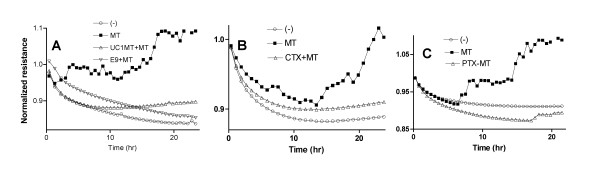
Inhibitors of MT chemotaxis. A: Monoclonal anti-metallothionein antibody blocks the chemotactic response of Jurkat T cells to 20 μM metallothionein gradient. Affinity-purified metallothionein (20 μM) was incubated with antibody (clone UC1MT or E9) and then added to the chemoattractant well. Controls were performed with metallothionein alone (MT), medium alone (-), or metallothionein preincubated with isotype-matched control antibody (not shown). B: Cholera toxin (CTX) inhibits chemotactic response to metallothionein. Jurkat T cells were preincubated with or without 0.133 μg/106 cells/ml CTX at 37°C for 1 h and then added to the cell well. Chemotactic responses of toxin-treated cells to MT (CTX-MT) were compared to untreated cells (MT) and untreated cells without an MT gradient (-). C: Pertussis toxin (PTX) blocks the chemotactic response to metallothionein. Jurkat T cells were preincubated with or without 200 ng/106 cells/ml PTX at 37°C for 16 h. Chemotactic responses of toxin-treated cells to MT (PTX-MT) was compared to untreated cells (MT) and untreated cells without an MT gradient (-). Each figure is a representative more than four independent experiments performed in triplicate.